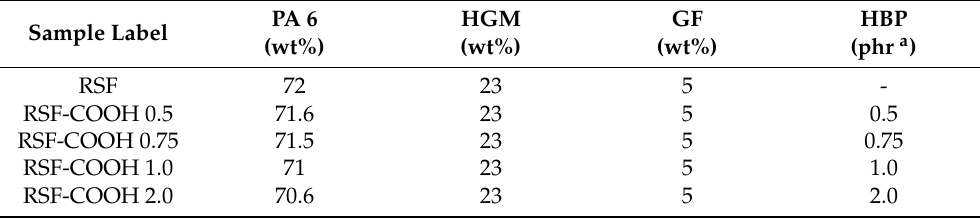
Table 1. Composition and identification details of prepared samples referred to as syntactic foams (SF), consisting of different PA 6, HGM, GF, and HBP contents.